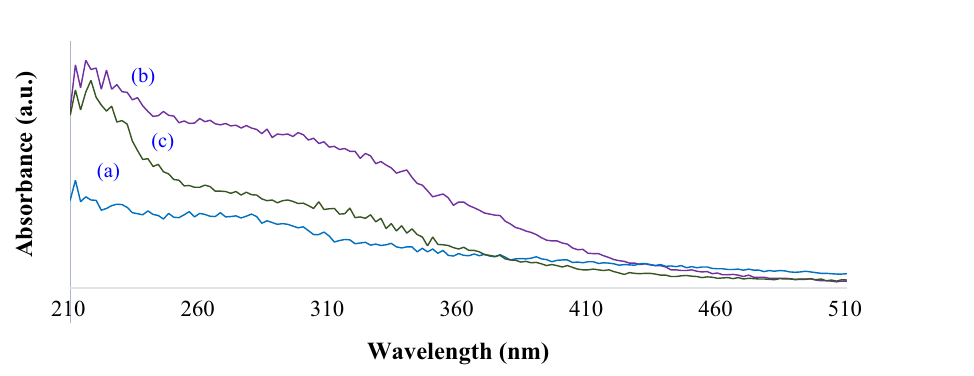
Figure 3. DRUV spectra of the chitosan ( a ), cellulose ( b ) and Cs-EDTA-Cell ( 1 ,